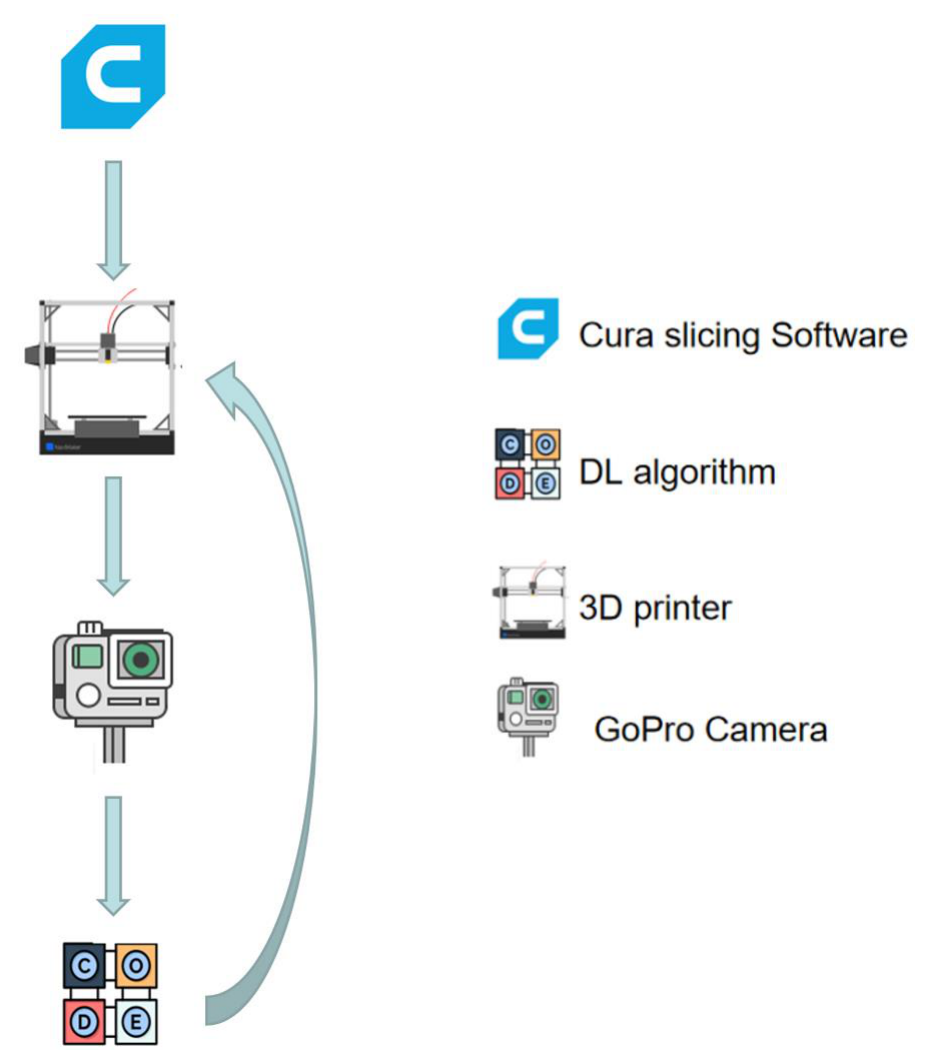
Figure 1. Schematic of the system. Abbreviations: DL, deep learning; 3D, three-dimensional.